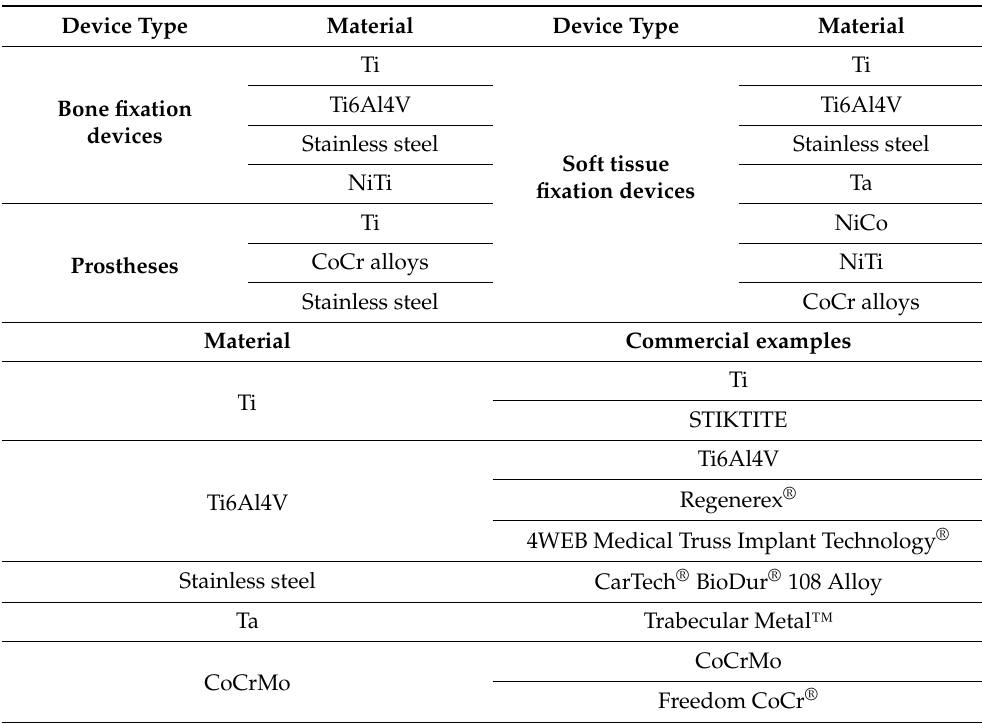
Table 3. An overview of the metallic materials used in orthopedic devices cleared or approved by the FDA (adapted from the U.S. Food and Drug Administration, “Biological Responses to Metal Implants” [62]), with some commercial